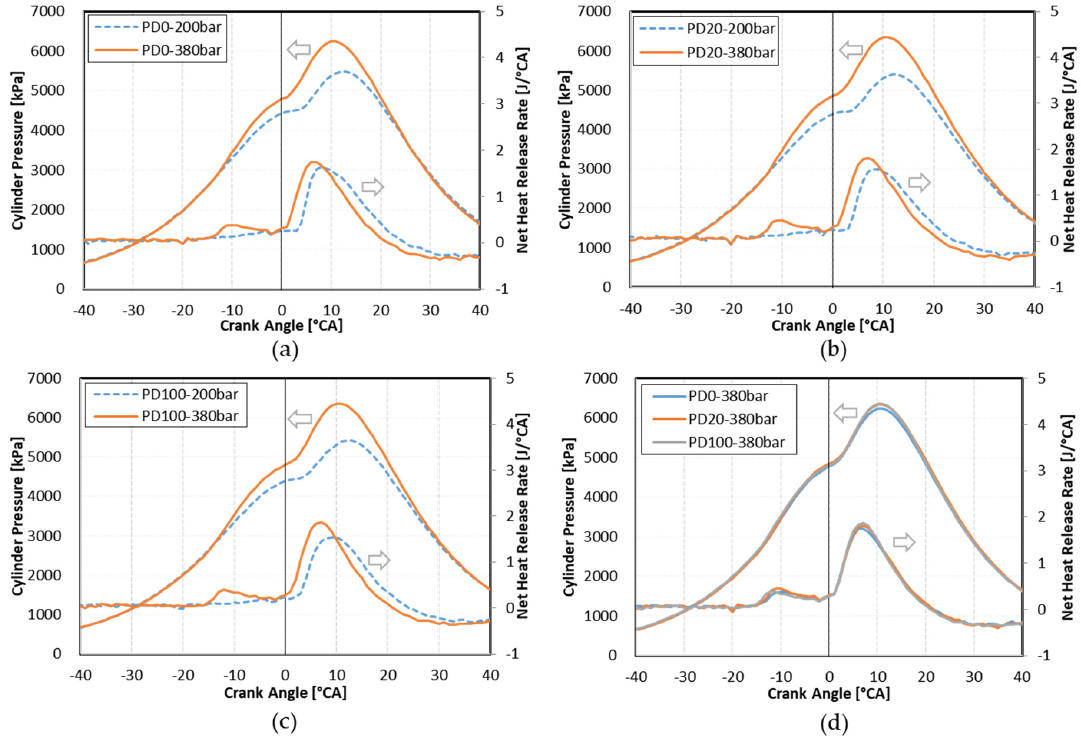
Figure 3. Combustion pressure and heat release rate. ( a ) PD0, ( b ) PD20, ( c ) PD100, and ( d ) all test fuels under 380 bar.